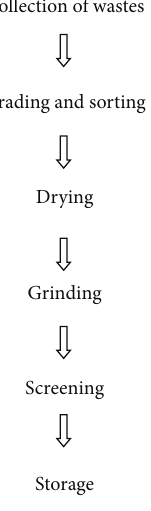
Figure 1: Flowsheet for feedstock and inoculum preparation.